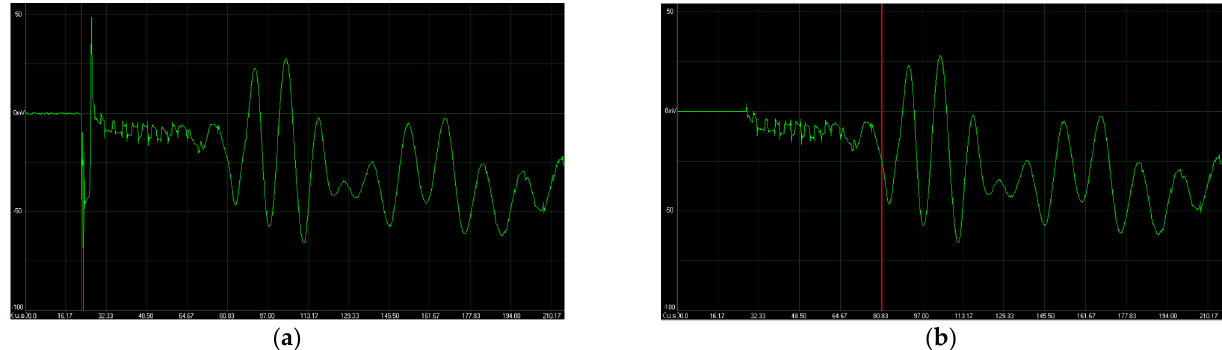
Figure 7. ( a ) AE waveforms containing crosstalk signals; ( b ) AE waveform of the crosstalk signal after the blanking pro- cess.